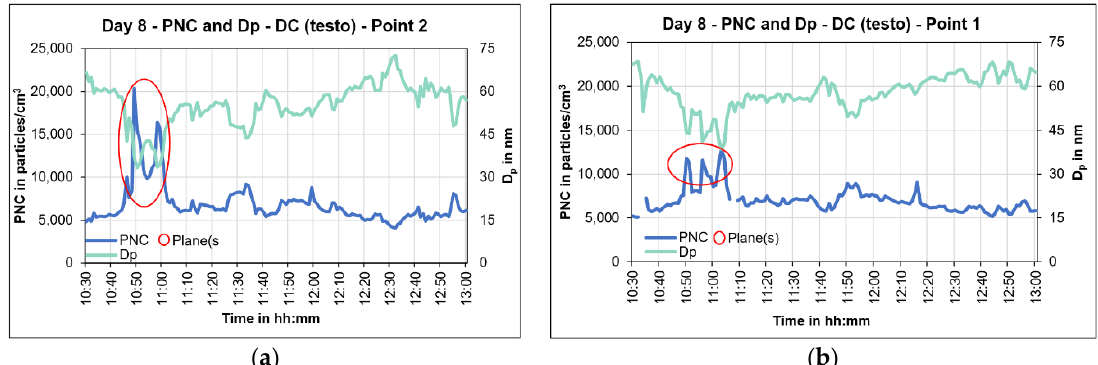
Figure 11. Day 8 simultaneous UFP measurements at ( a ) point 2 and ( b ) point 1.